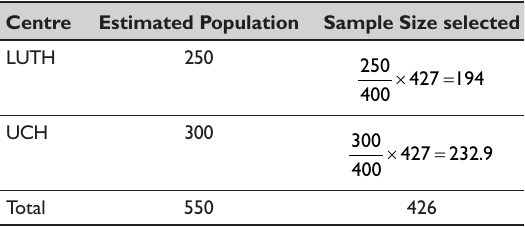
Table A: Proportionate allocation of study